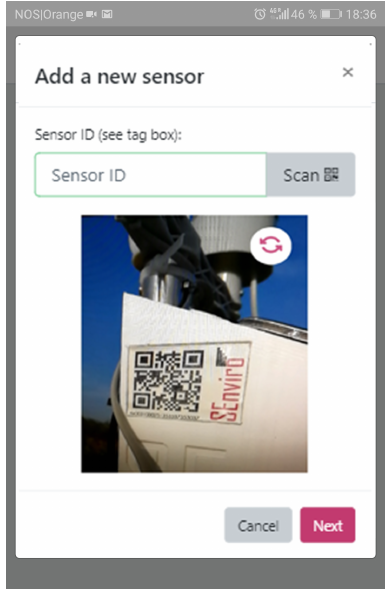
Figure 12. A screen capture of the SEnviro connect, where the wizard to add IoT devices is